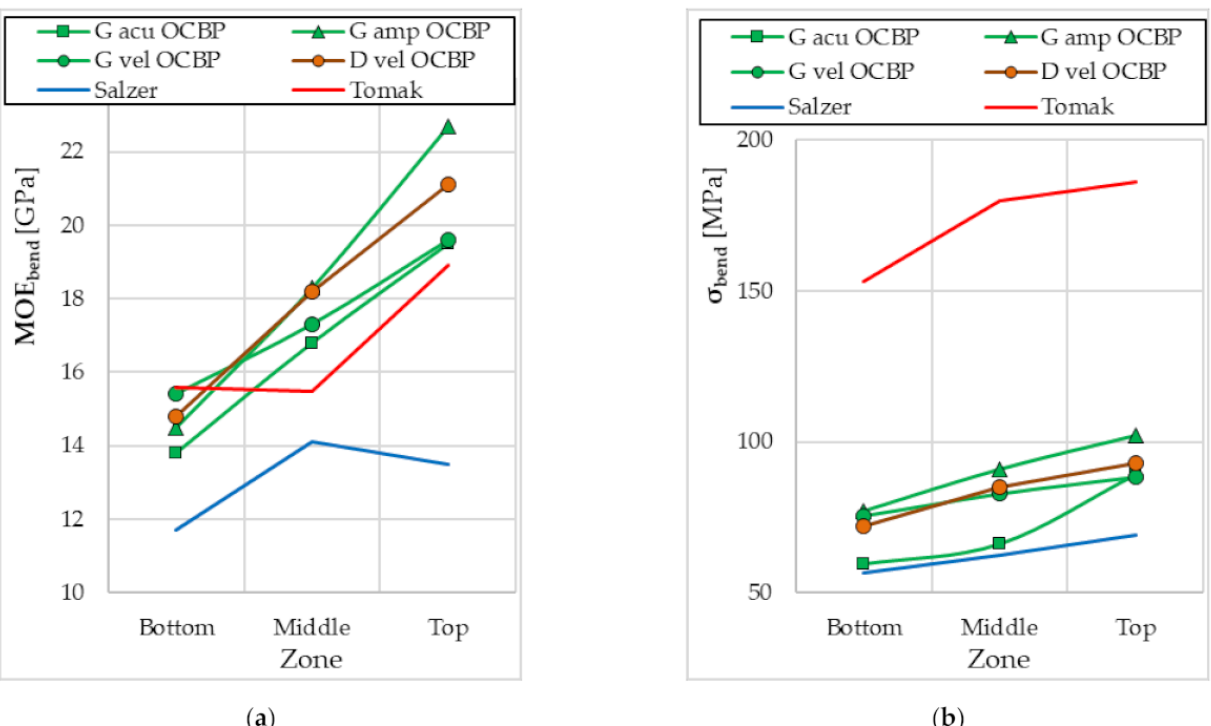
Figure 13. Changes in the values of biomechanical parameters depending on the bamboo shoot zone obtained in the three-point bending tests: ( a ) modulus of elasticity in bending MOEbend; ( b ) maximum stress in bending σ bend. G acu—Guadua aculeata bamboo in a green state; G amp— Guadua amplexifolia bamboo in a green state; G vel—Guadua velutina bamboo in green state; D vel—Guadua velutina bamboo in a dry state; OCBP—Ordonez-Candelaria and B á rcenas-Pazos 2014 [60]; Salzer—Salzer et al. 2018 [57]; Tomak—Tomak et al., 2012